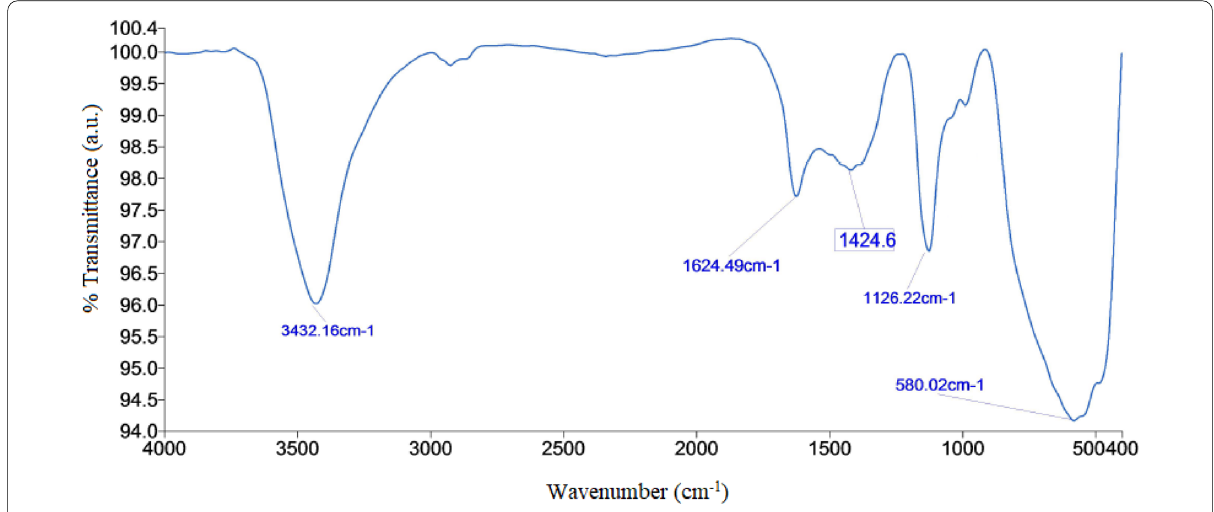
Fig. 2 FTIR spectrum for green-synthesised Ag–TiO 2 NCs